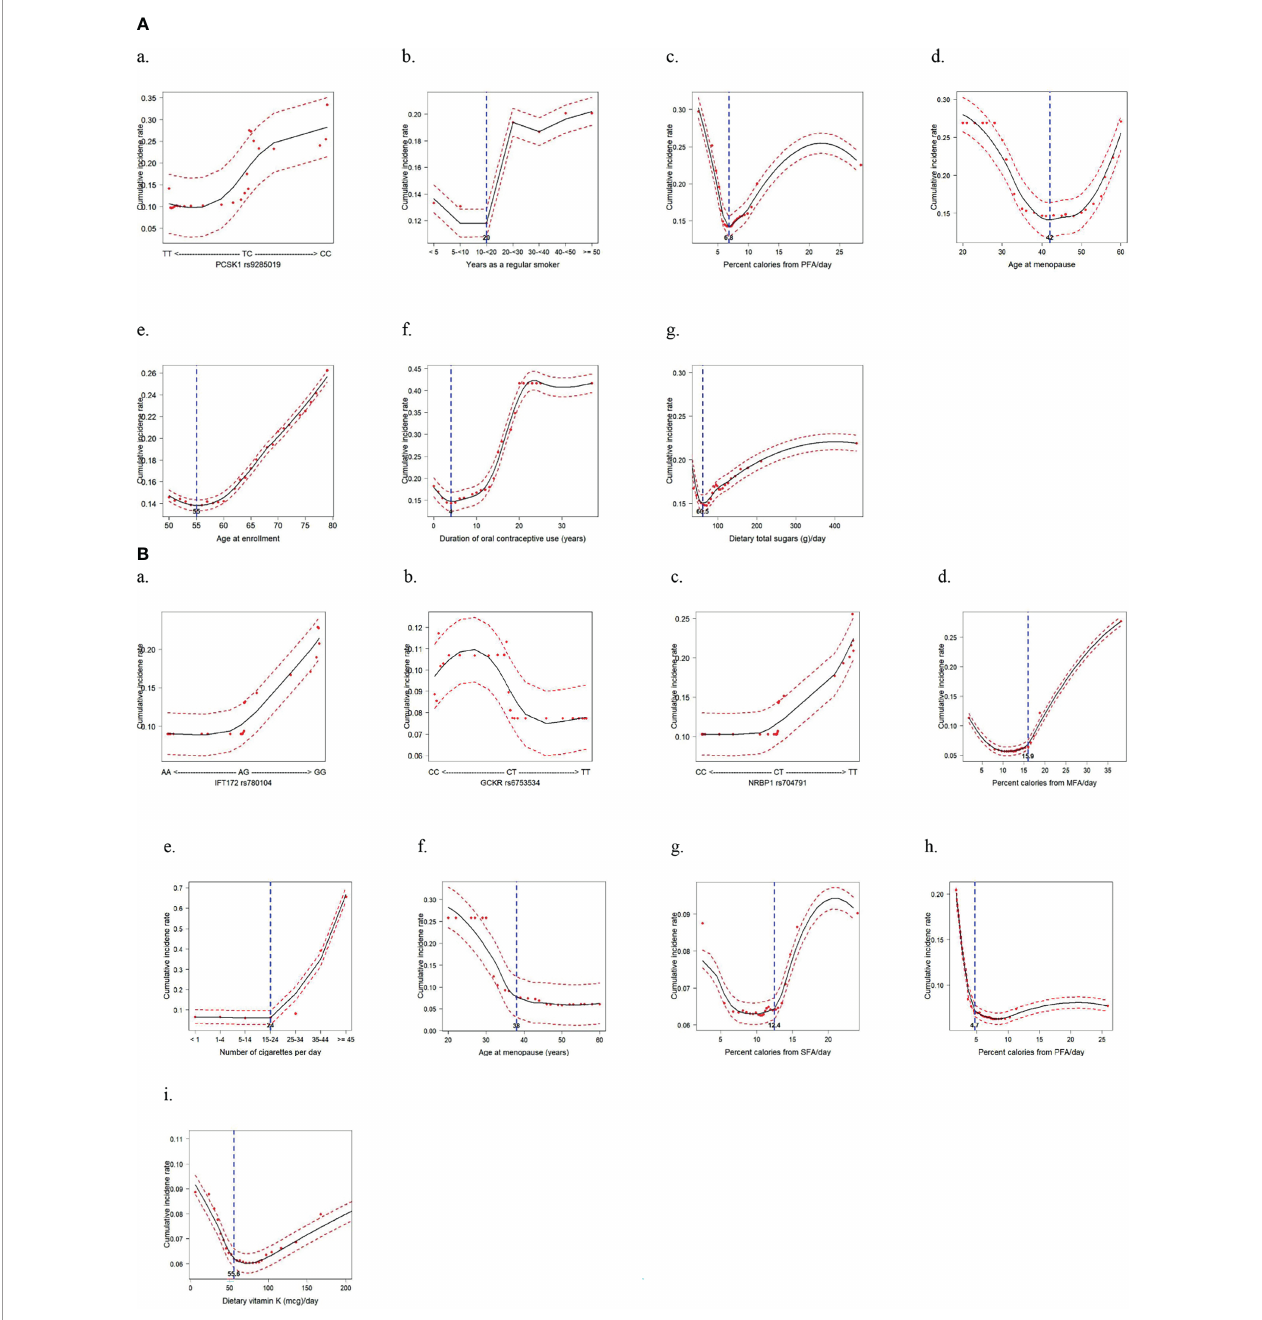
FIGURE 3 | Cumulative incidence rate of colorectal cancer for the topmost predictive genetic and lifestyle variables selected from a random survival forest analysis (Dashed red lines indicate 95% con fi dence intervals. (A) African American women: 1 genetic and 6 lifestyle factors. (B) Hispanic American women: 3 genetic and 6 lifestyle